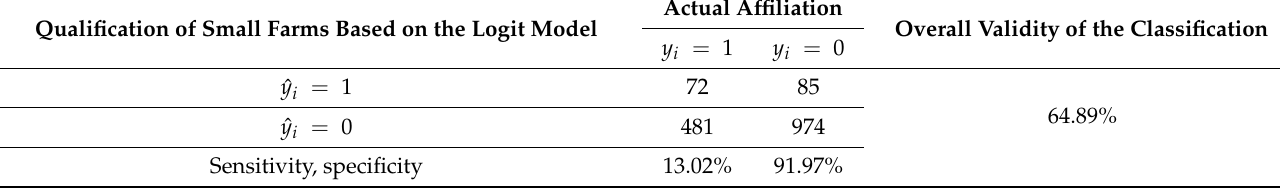
Table 5. Accuracy of classification of the logit model.